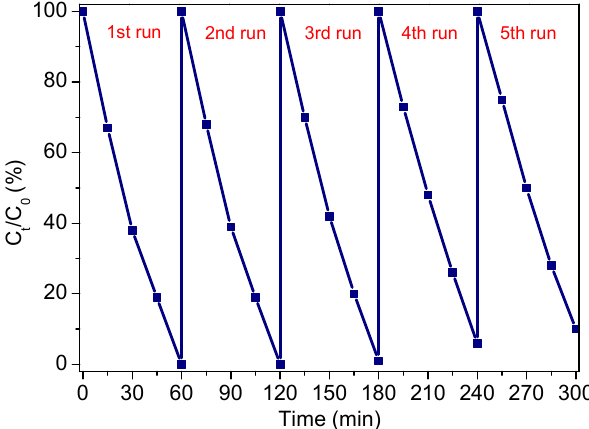
Figure 14. Cyclic photodegradation curve for Ag/Bi 2 O 2 CO 3 /α-Bi 2 O 3 .